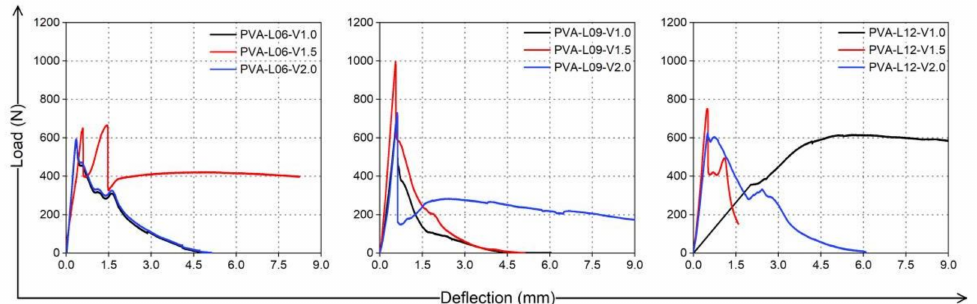
Figure 10. Full load-deflection curves of PVA fiber-reinforced coral cement-based composites speci- mens in the bending